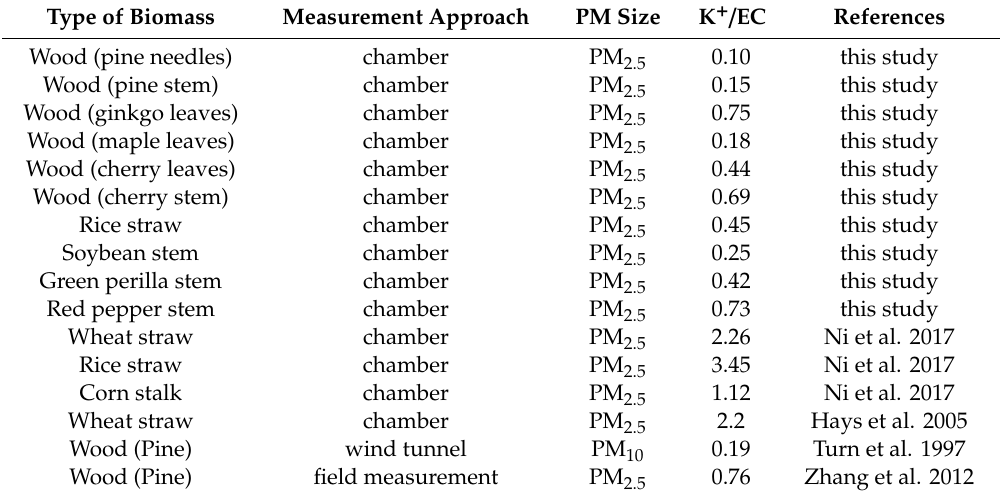
Table 3. Ratios of K + / elemental carbon (EC) for crop residue emissions from this study compared to similar measurements reported